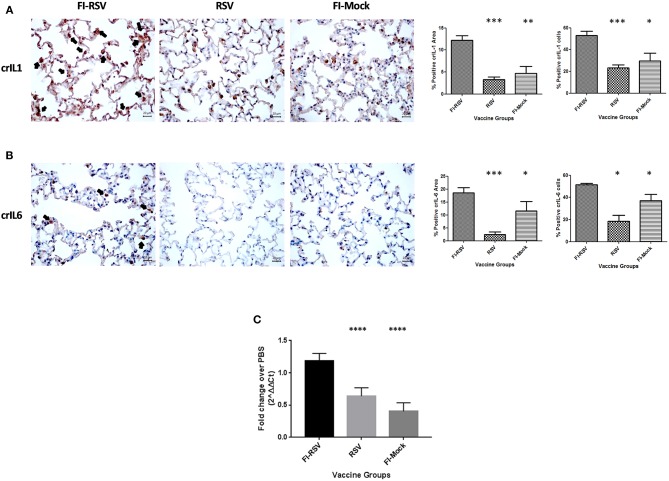
Higher expression levels of IL-1 and IL-6 cytokines and chemoattractant GRO in FI-RSV vaccinated cotton rats. Detection of pulmonary interleukin-1 (A) and interleukin-6 (B) was conducted using immunohistochemistry. For each section 15 fields of view were counted for positively stained cells in the alveoli (40× magnification). Black arrows indicate the positive staining by diaminobenzidine (DAB) substrate. The percentages of total area stained as well as the percentages of positive cells for each cytokine were calculated using one-way ANOVA, *p < 0.05, **p < 0.01, ***p < 0.001 (n = 6). Gene expression of GRO (C) in the lungs was normalized to β-actin and fold change was expressed over the PBS group using the ΔΔCt method. Statistical differences in fold change were calculated using one-way ANOVA, *p < 0.05, **p < 0.01, ***p < 0.001, ****p < 0.0001 (n = 6).